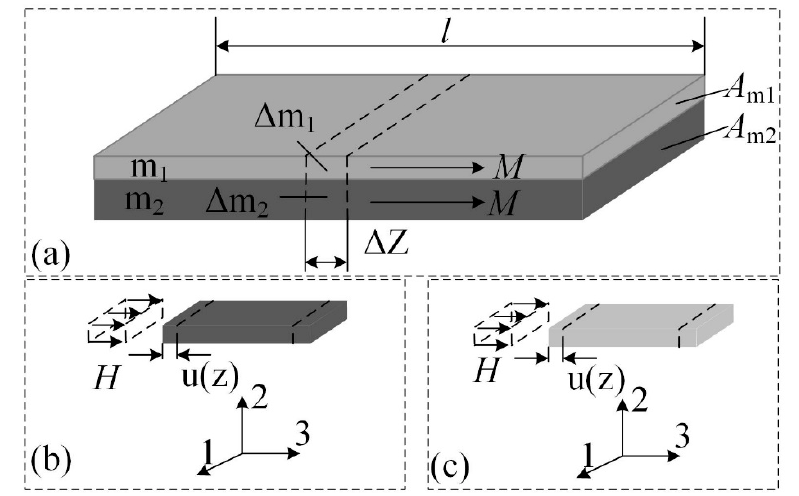
Figure 1. ( a ) Schematic diagram of magnetization-graded ferromagnetic material FeCuNbSiB / Ni. The local coordinate systems in ( b ) FeCuNbSiB ribbon and ( c ) Ni plate when the magnetic field is applied along the longitudinal 3-direction. The symbol M is magnetization. The m 1 and m 2 is the mass of the FeCuNbSiB ribbon and Ni plate, respectively. The ∆ m 1 and ∆ m 2 are small mass units in the FeCuNbSiB ribbon and Ni plate, respectively. The A m 1 and A m 2 is the cross-sectional area of the FeCuNbSiB ribbon and Ni plate, respectively. The l is the length of FeCuNbSiB / Ni. The H is the applied magnetic field. The u ( z ) is the displacement.